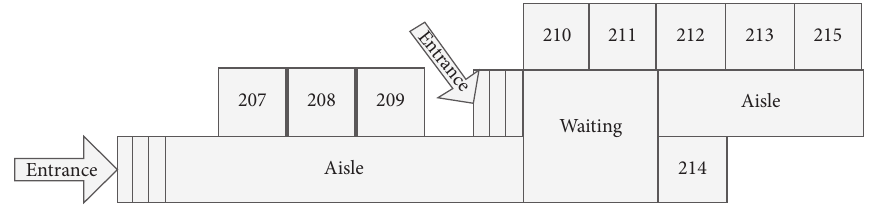
Figure 1: The floor layout of the Industrial Engineering Department of